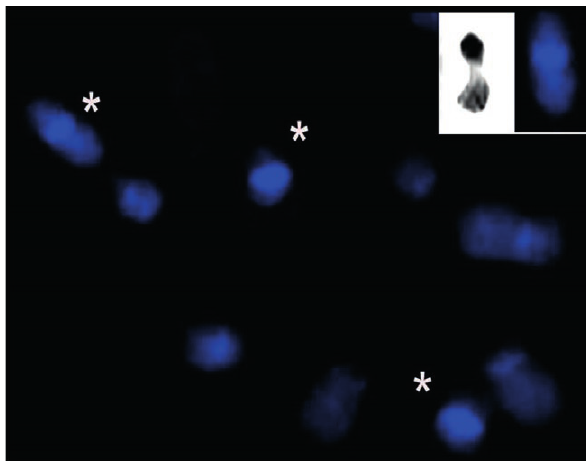
Figure 5. Chromosomes of Dasylirion cedrosanum Trel. stained with DAPI. More intensely marked areas of constitutive heterochro- matin can be observed (chromosomes marked with an asterisk). In the upper-right corner, the CBW bands can be compared with the zones detected using DAPI, thus confirming the distribution in the chromosomes of the constitutive heterochromatin.